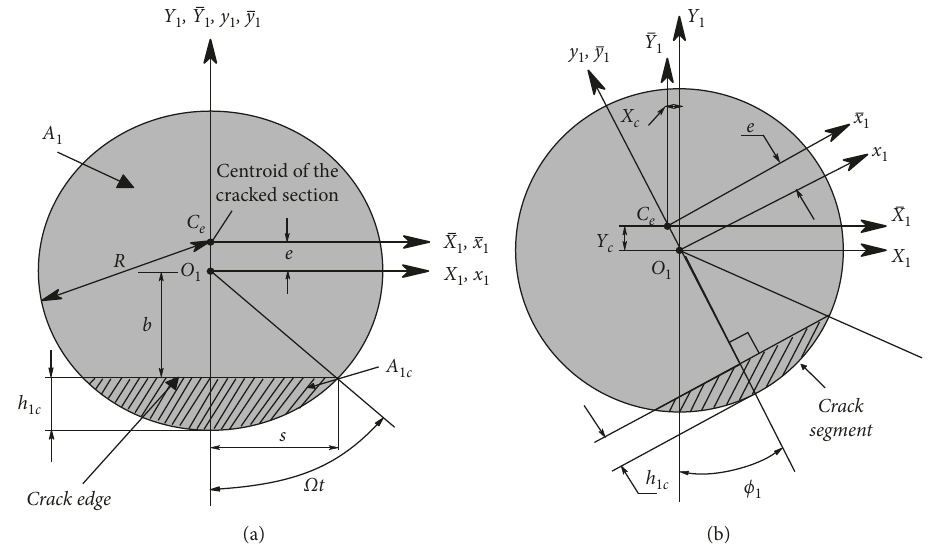
Figure 4: Cracked shaft model coordinates (a) in a fixed frame and (b) after the driveshaft